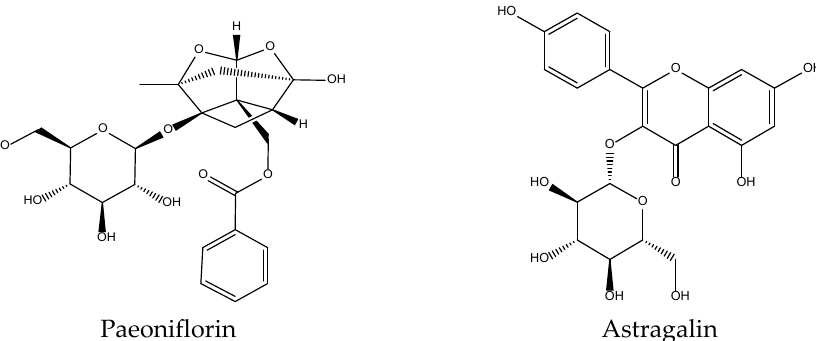
Figure 12. Bioactive anti-inflammatory (eicosanoid inhibition) and antioxidant principles from Forsythia suspensa .